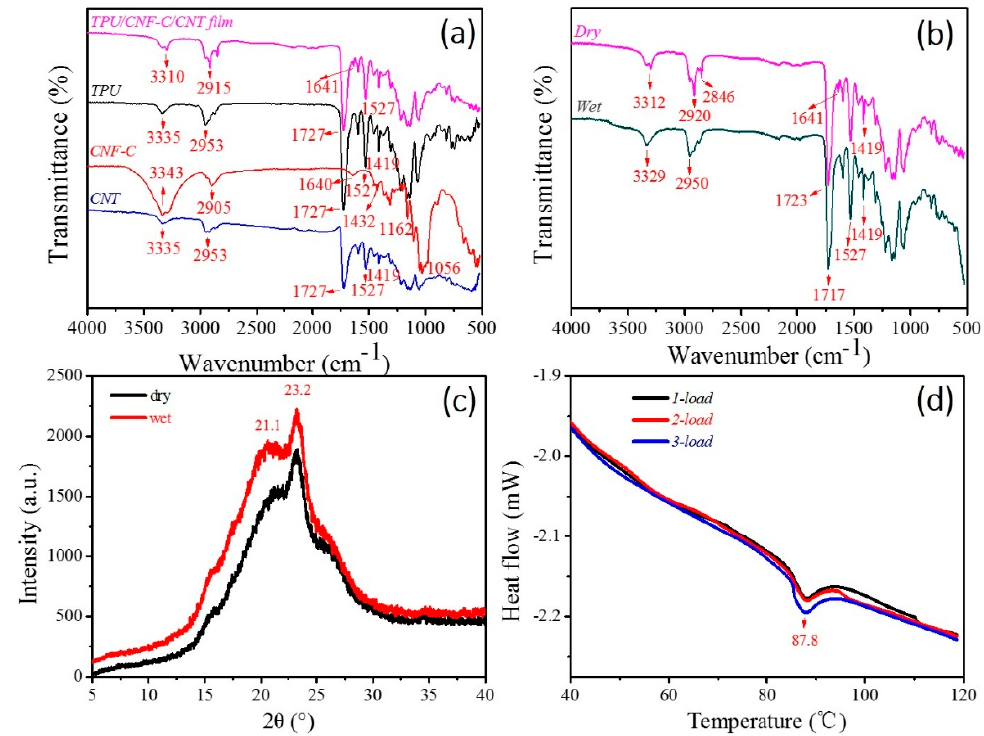
Figure 2. Chemical structure and physical properties of as-made water-responsive polyurethane composition, ( a ) FT-IR results of TPU/CNF-C/CNTs film, TPU, CNF-C, CNTs; ( b ) FT-IR results of TPU/CNF-C/CNTs films under original (dry) and water (wet); ( c ) XRD patterns of TPU/CNF-C/CNTs film under dry and wet states; ( d ) DSC characterization of TPU/CNF-C/CNTs film from 40 to 120 °C for three loads.